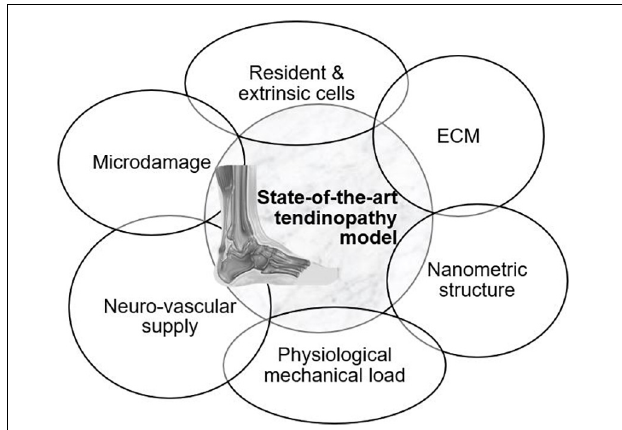
FIGURE 8 | Requirements for the state-of-the-art tendinopathy